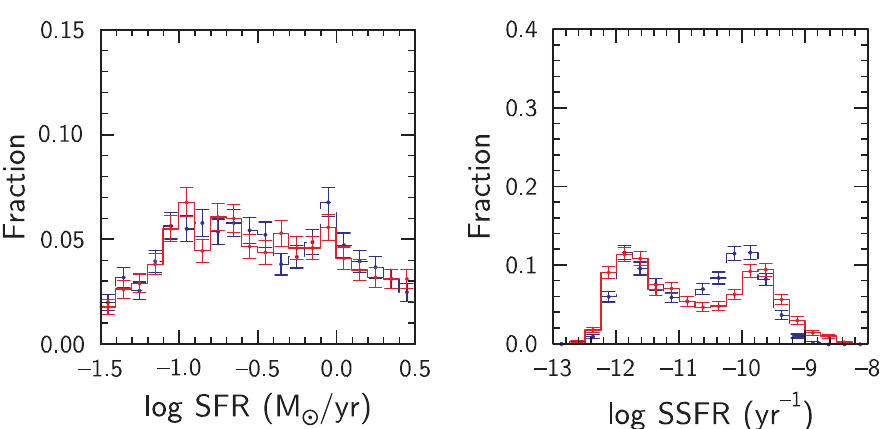
Fig. 5. SFR and SSFR distributions for the pair subsample and the new control sam- ple with the same r p and ∆ V limits but with the requirement to have the same numbers of galaxies and the same redshift distribution as the pair subsample. Designations are the same as in Figure 1.